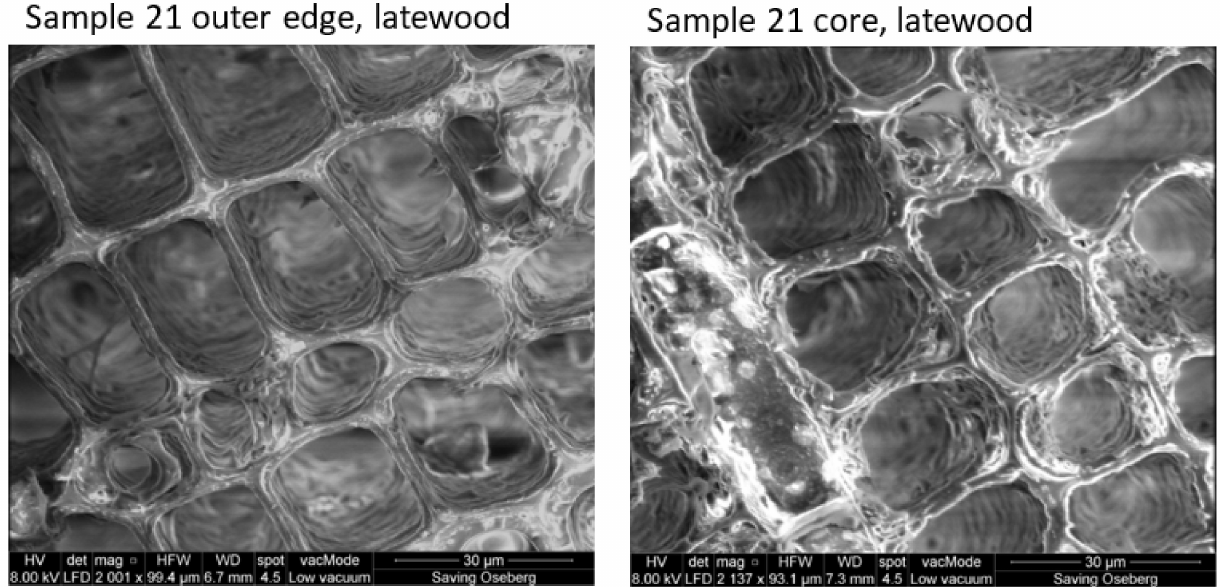
Figure 8. SEM images of the transverse faces of 30% FB01-treated sample 21. The left image is taken from the outer edge and the right image from the core of the sample. The spongy nature of the secondary walls appears to be reduced in both the surface and core, compared to the untreated reference shown in Figure 6. This may be attributed to the polymer within the cell